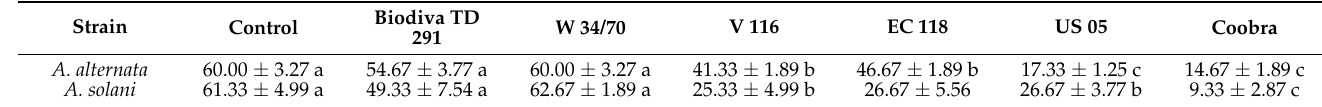
Table 4. Effect of antagonistic yeast strains spraying on the DSI (%) of A. alternata and A. solani on potted potato plants after seven days in greenhouse conditions.